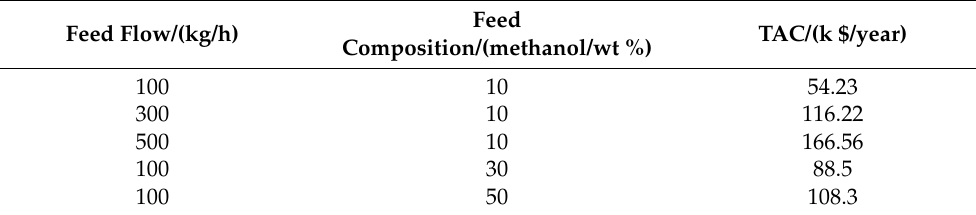
Table 1. Optimized calculation results of extractive distillation for the methanol-toluene azeotrope